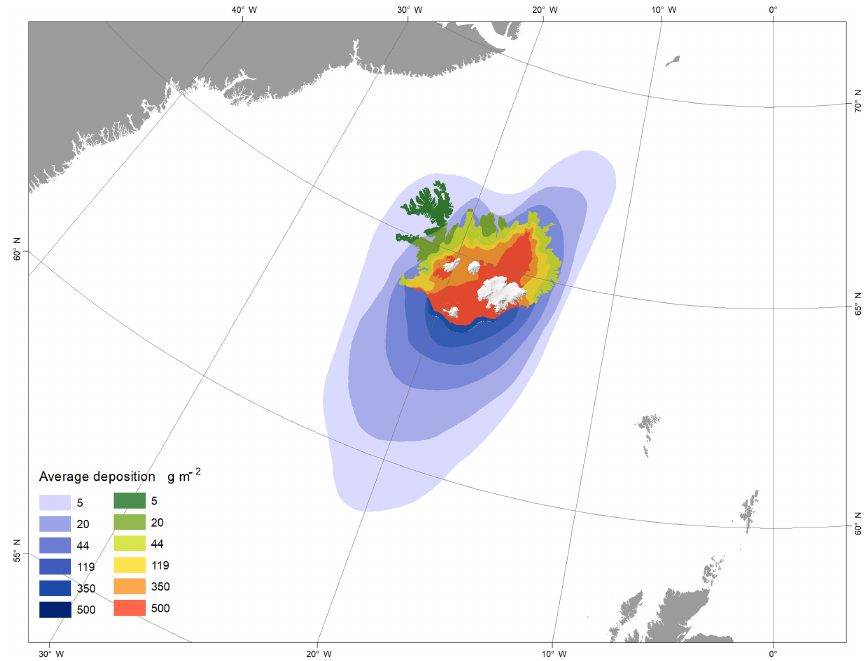
Figure 4. Annual dust deposition rates of Icelandic dust (Arnalds et al.,